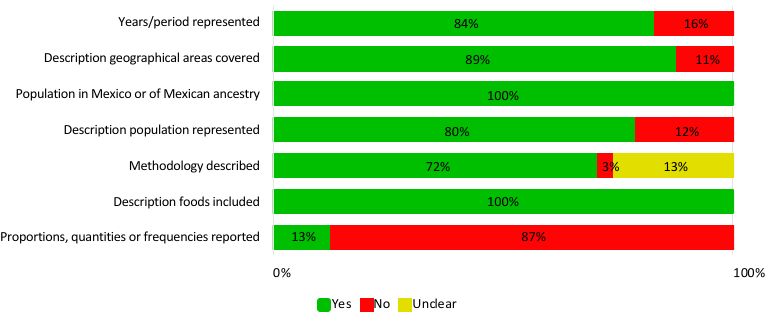
Figure 2. Proportion of included articles reporting the study quality index components.